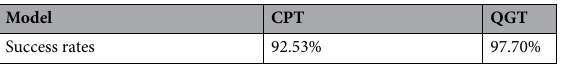
Model Success Table 2. Comparison of the success rates in CPT model and QGT model.